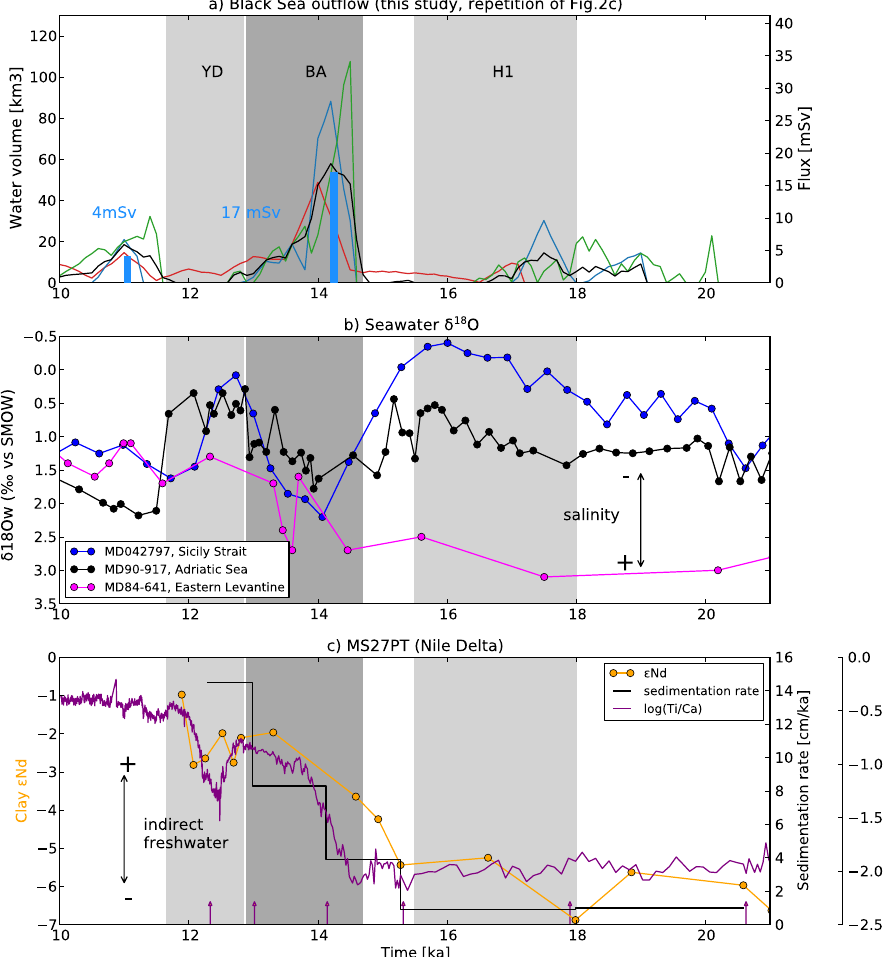
Figure 4. ( a ) Black Sea outflow chronology as calculated in this study (repetition of Fig. 2c). ( b ) δ 18 O w from 21 to 10 ka in marine cores MD90-917 (41°17 ′ N, 17°36 ′ E; water depth: 1010 m, South Adriatic Sea 55 ), MD07- 2797 (36°57 ′ N, 11°40 ′ E; water depth: 771 m, Strait of Sicily 56,57 ) and MD84-641 (33°02 ′ N, 33°38 ′ E; water depth: 1375 m, Eastern Levantine basin 58 ). ( c ) Sedimentation rate, clay-εNd (fraction lower than 2 micron) in MS27PT (31°47 ′ N, 29°27 ′ E; water depth: 1389 m, Nile delta), decimal logarithm of the Ti/Ca ration scanned with XRF in